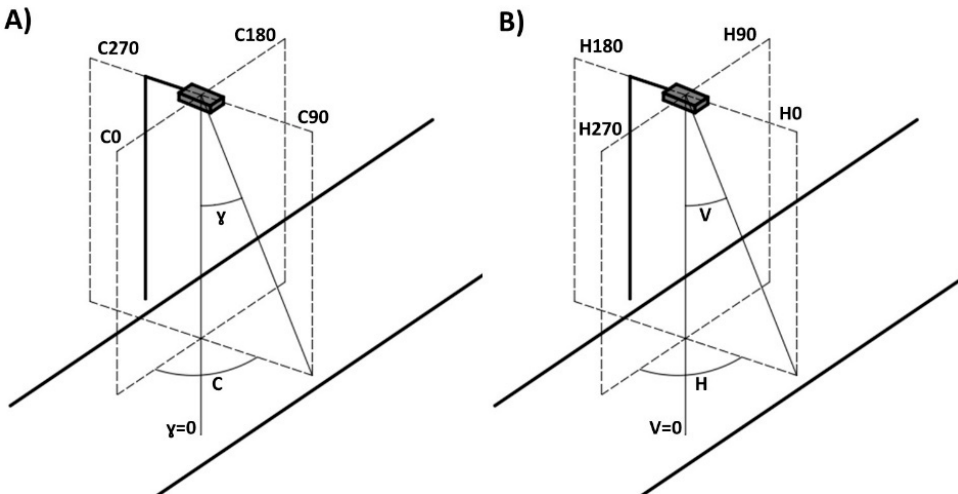
Figure 2. Typical photometric coordinate systems: ( A ) C-gamma and ( B ) “VH” by IESNA.